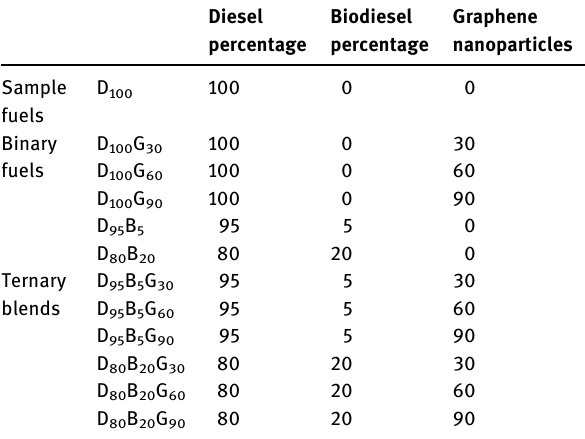
Table 3: Summary of surveyed fuel